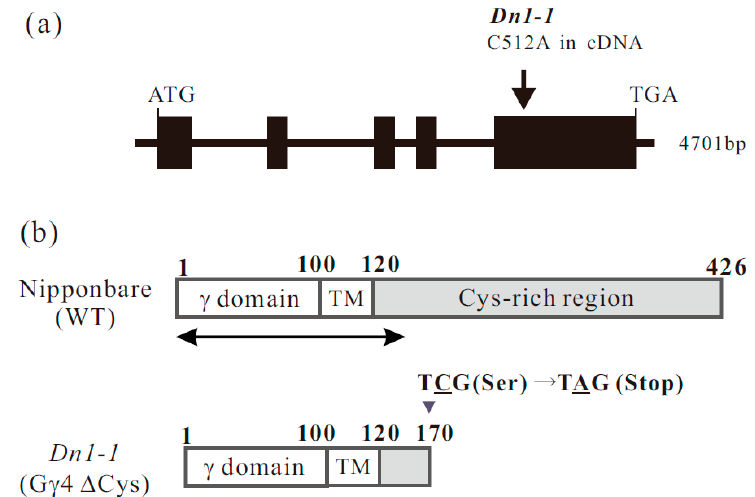
Figure 1. Genome and protein structure of RGG4 / DEP1 / DN1 / qPE9-1 / OsGGC3 . ( a ) Genome structure of RGG4 / DEP1 / DN1 / qPE9-1 / OsGGC3 and position of the mutation in RGG4 / DEP1 / DN1 / qPE9-1 / OsGGC3 mutant Dn1-1 . The one-base substitution (C512A in full-length cDNA) in Dn1-1 was in a codon in which TCG (cysteine) was changed to TAG (stop codon). ( b ) Protein structure of the product of RGG4 / DEP1/DN1 / qPE9-1 / OsGGC3 in wild type (WT) (G γ 4) and Dn1-1 (G γ 4 Δ Cys). The canonical γ -domain region is shown as γ domain. Putative transmembrane domain is indicated as TM. The cysteine-rich region is indicated by the gray box. An arrow under WT G γ 4, which covers 137 amino acid residues from the N-terminus, is the region used for recombinant proteins, such as the thioredoxin (Trx)-tagged G γ 4 domain protein (Trx-G γ 4 domain protein), which was used as the antigen, and glutathione S transferase (GST)-tagged G γ 4 domain protein (GST-G γ 4 domain protein), which was used for affinity purification of the antibody.